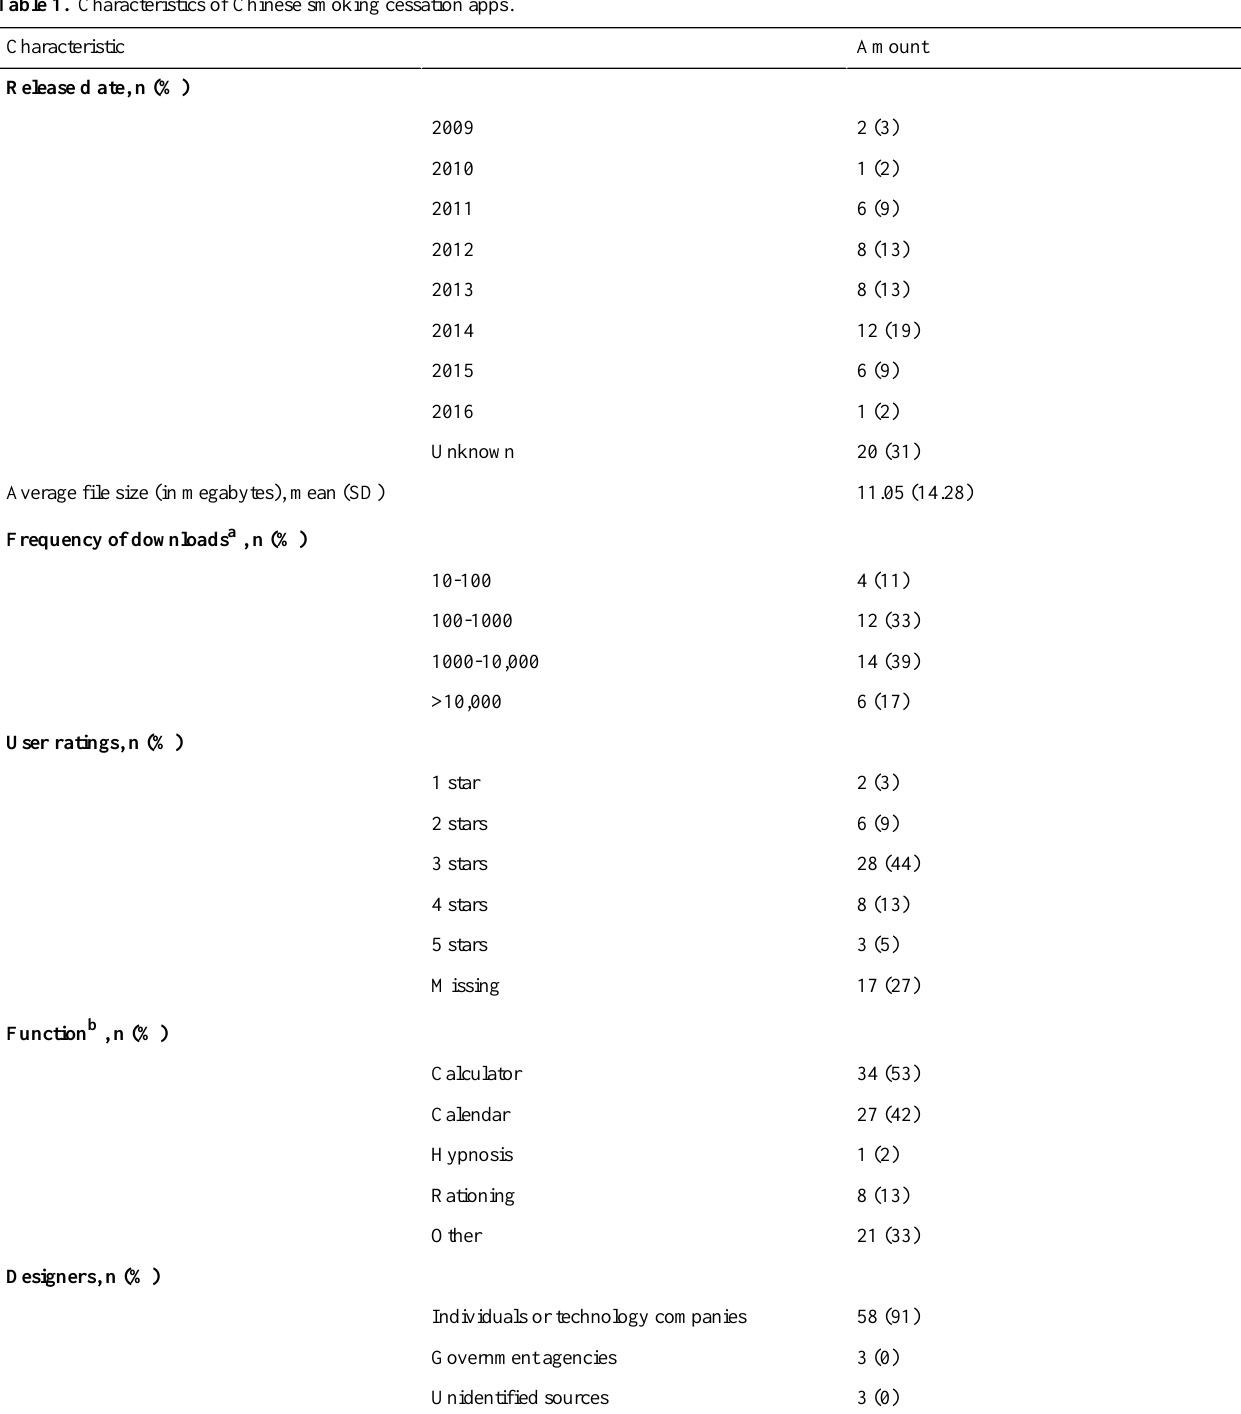
Table 1. Characteristics of Chinese smoking cessation apps.